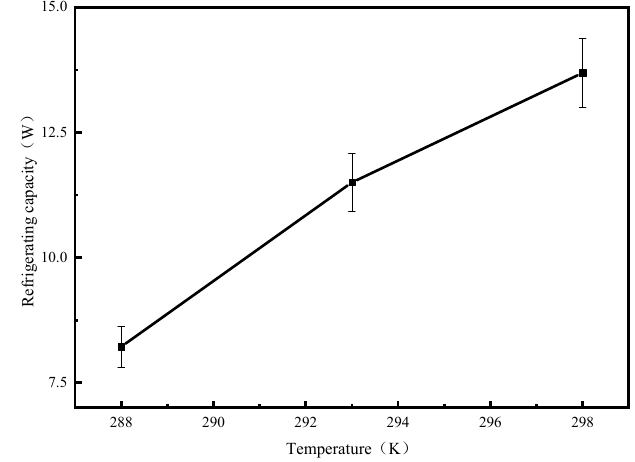
Figure 10. The curve of adsorption uptake of water vapor versus time.